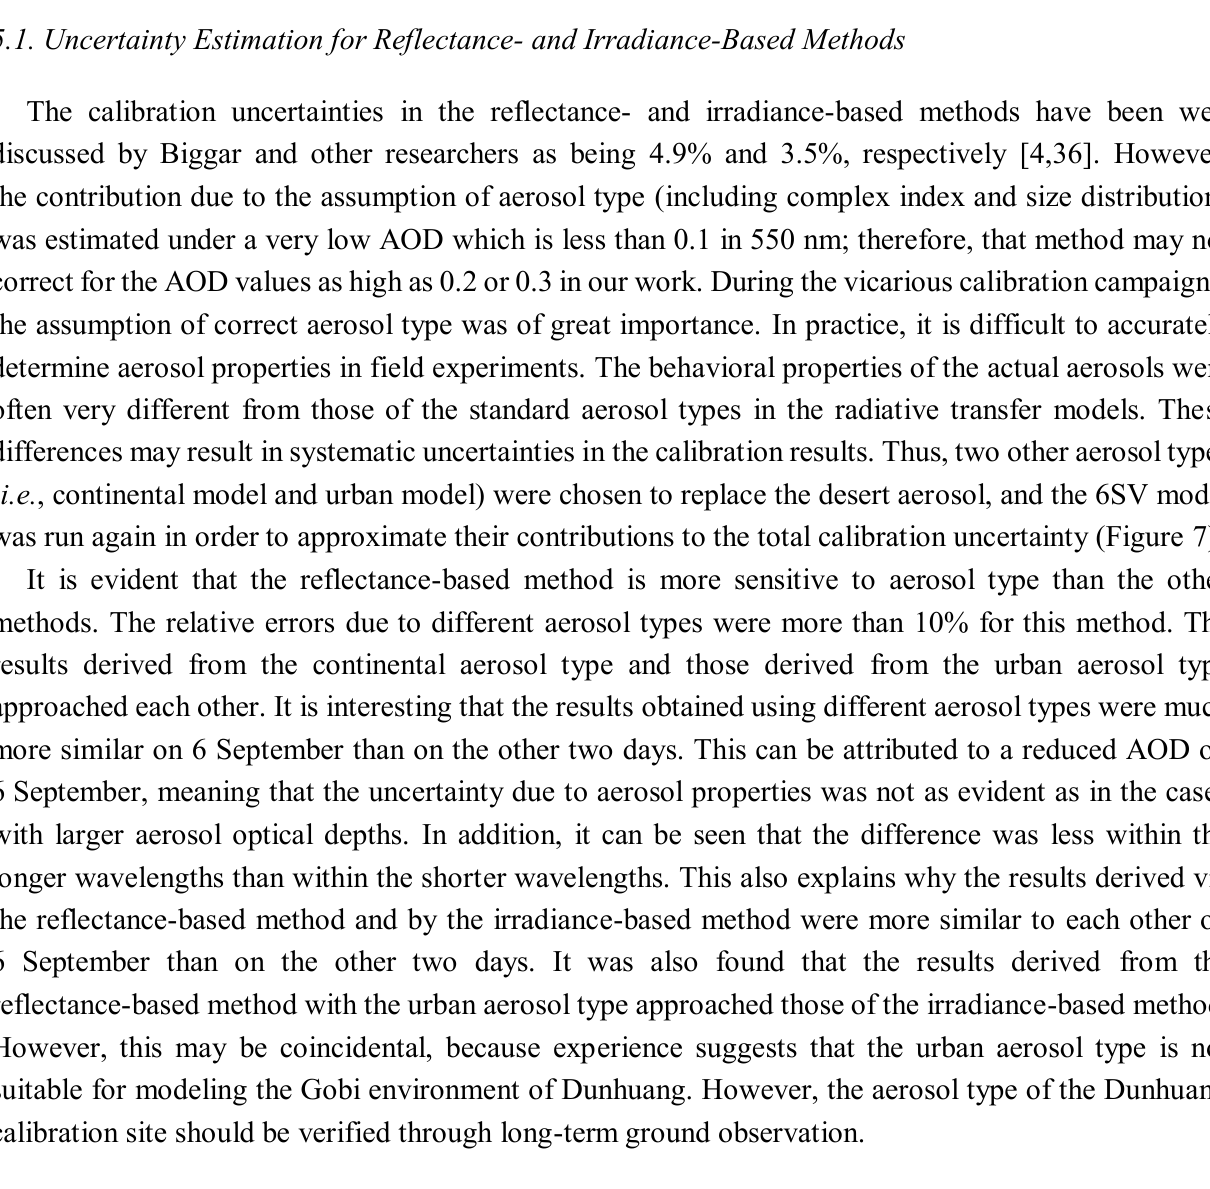
Figure 7. Results derived by reflectance-based method and irradiance-based method under different aerosol